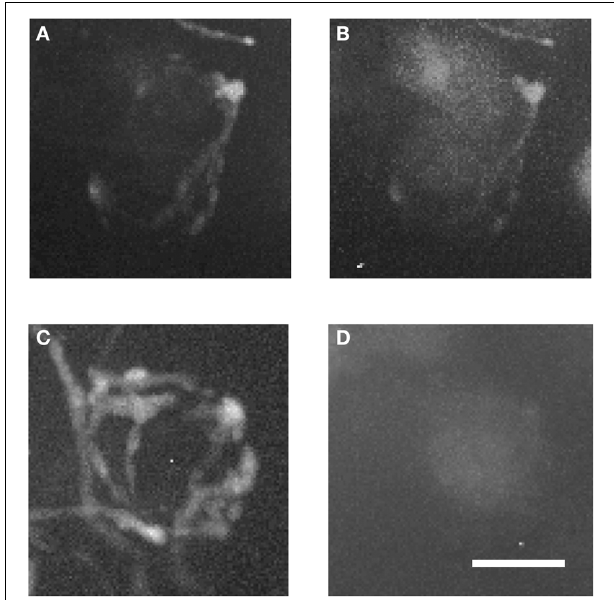
FIGURE 7 | Two magnified MNTB principal cells and their TMR-traced inputs. (A,B) are showing a cell located ipsilaterally to the injected VNTB, (C,D) a contralateral one. Note the structural differences between the two input types and the fact that the ipsilateral terminal can be seen in the green channel (coding for GlyT2-GFP). Scale bar: 25 µ